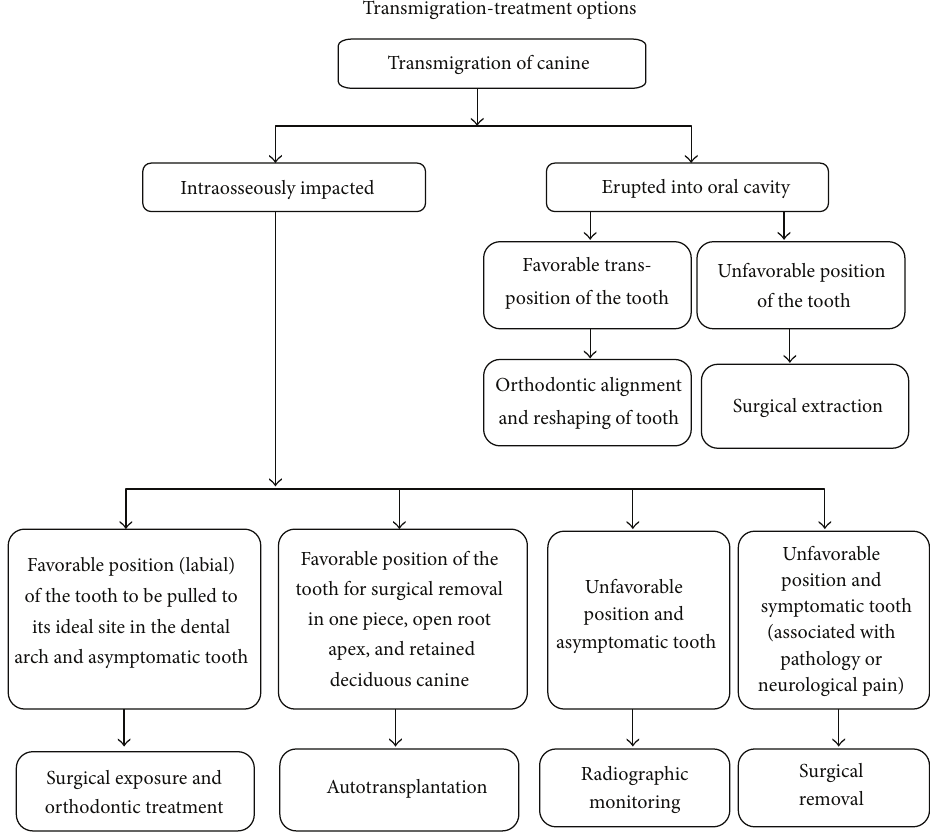
Figure 5: Flowchart depicting the various treatment options to aid in decision making for the management of canine transmigration.